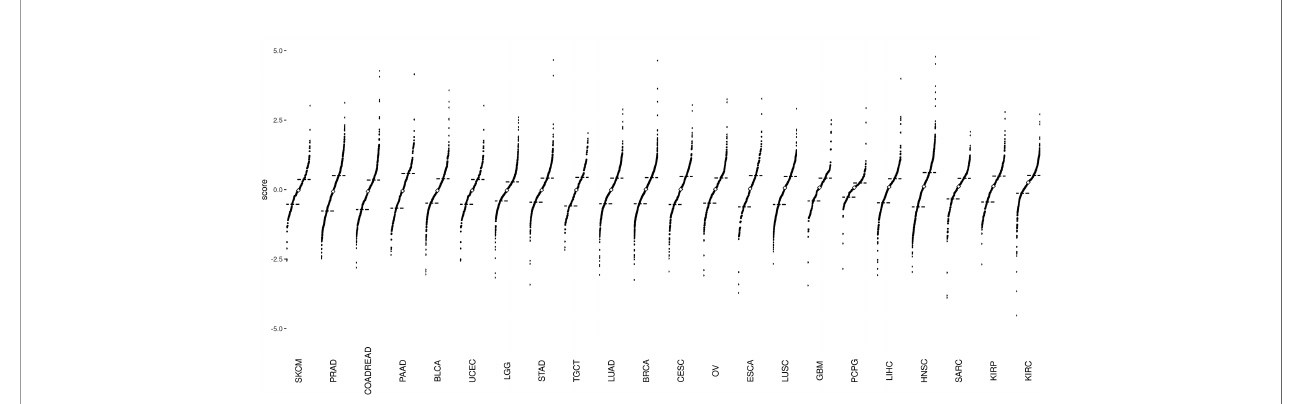
FIGURE 2 | Divergent dot plots for the distribution of epithelial – mesenchymal transition (EMT) scores across 22 cancer types: The plots are arranged in increasing order of median values. The black dashes represent the end of the fi rst quantile (25% mark) and the beginning of the fourth quantile (75% mark), respectively. The white diamond point corresponds to the median of EMT scores of all samples per cancer type. Skin Cutaneous Melanoma (SKCM) tumor samples have the lowest median EMT score, whereas Kidney Renal Clear Cell Carcinoma (KIRC) tumor samples have the highest median